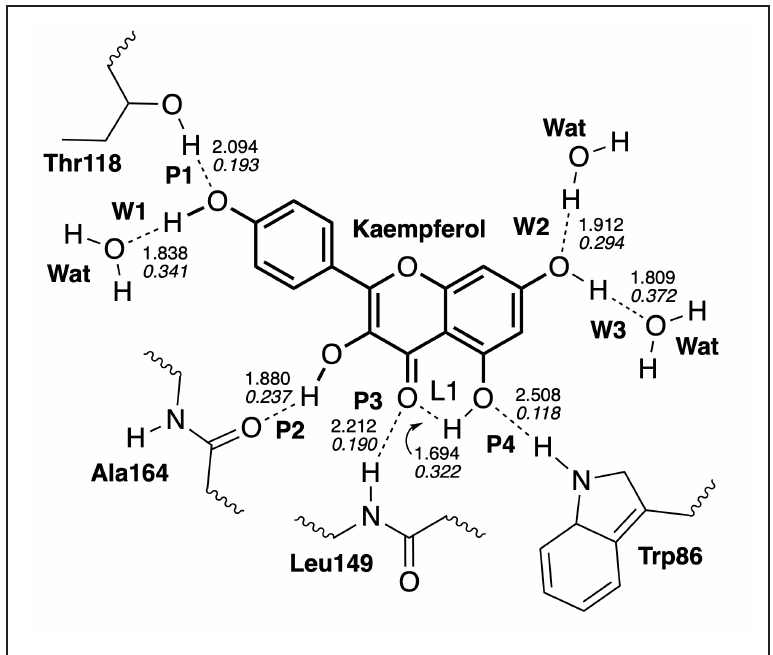
Figure 9. Hydrogen bonds in the Kaempferol-NS3 complex (dashed lines). Bond lengths are shown in the normal font, BSO values are shown in the italic font. ω B97X-D/6-31G(d,p)/AMBER level of